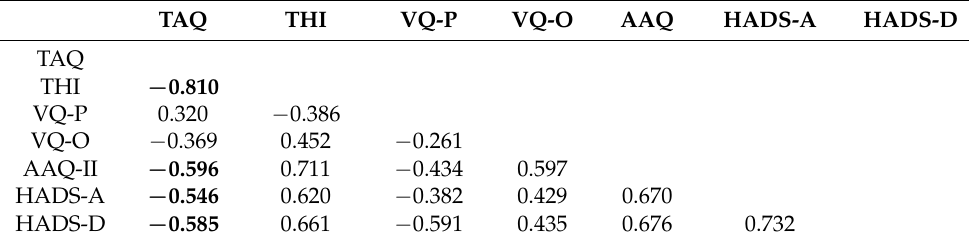
Table 4. Criterion and construct validity: correlation coefficients between